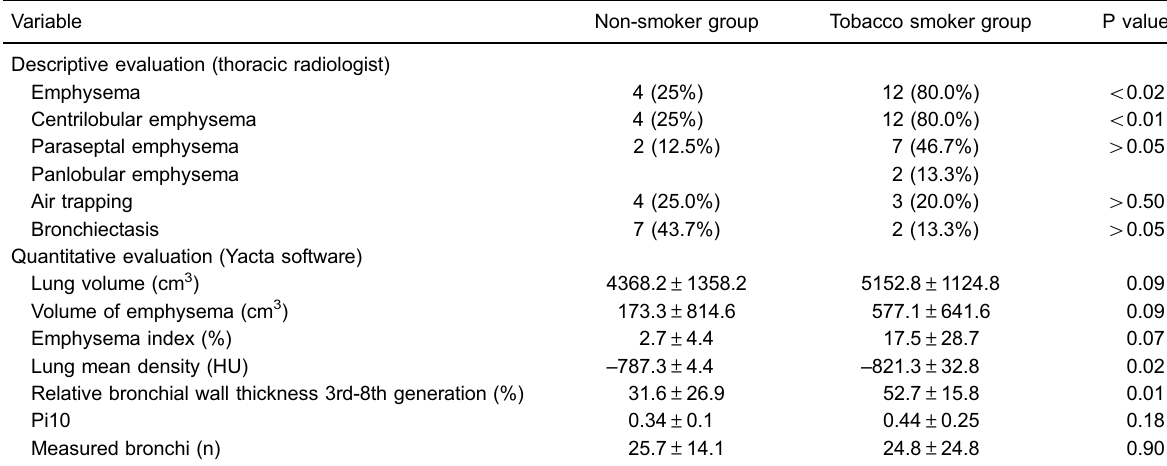
Table 5. High resolution computed tomography fi ndings according to chronic obstructive pulmonary disease groups.